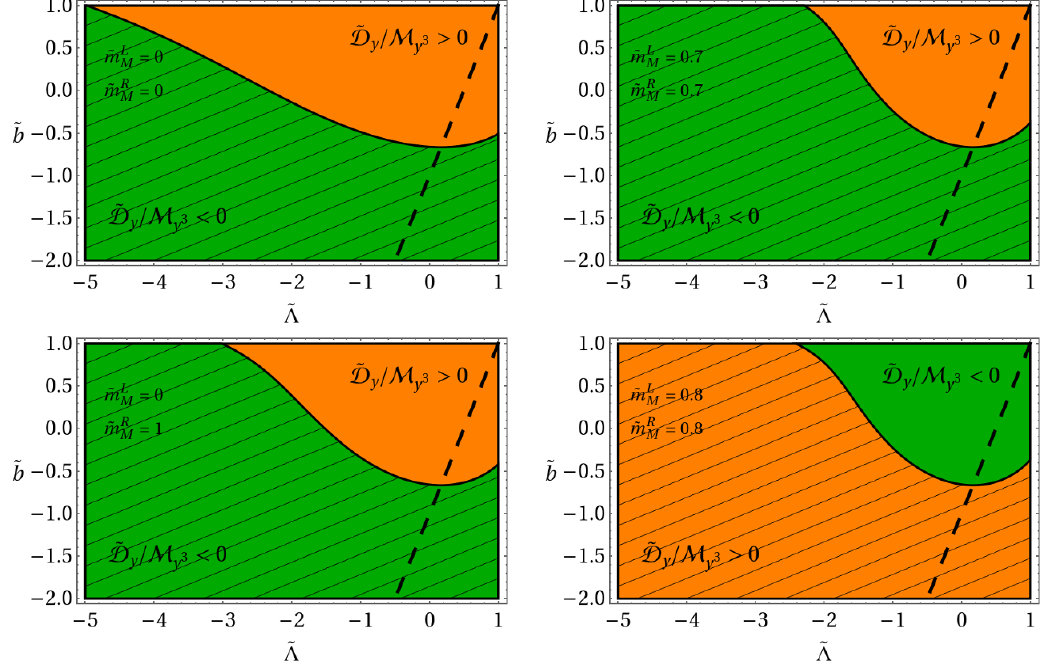
Figure 4 . Sign of ~ D y = M on the (~(cid:3), ~ b ) plane with ~ a = (cid:0) 0 : 5. Di(cid:11)erent plots correspond to di(cid:11)erent y 3 choices of the Majorana masses. The green (darker) region correspond to ~ D y = M < 0, while the y 3 orange (brighter) region indicates ~ D y = M > . The mesh lines stand for the region constrained only y 3 by ~ D y < 0. The dashed line indicates the pole 1 + ~ b (cid:0) 2~(cid:3) = 0 coming from the